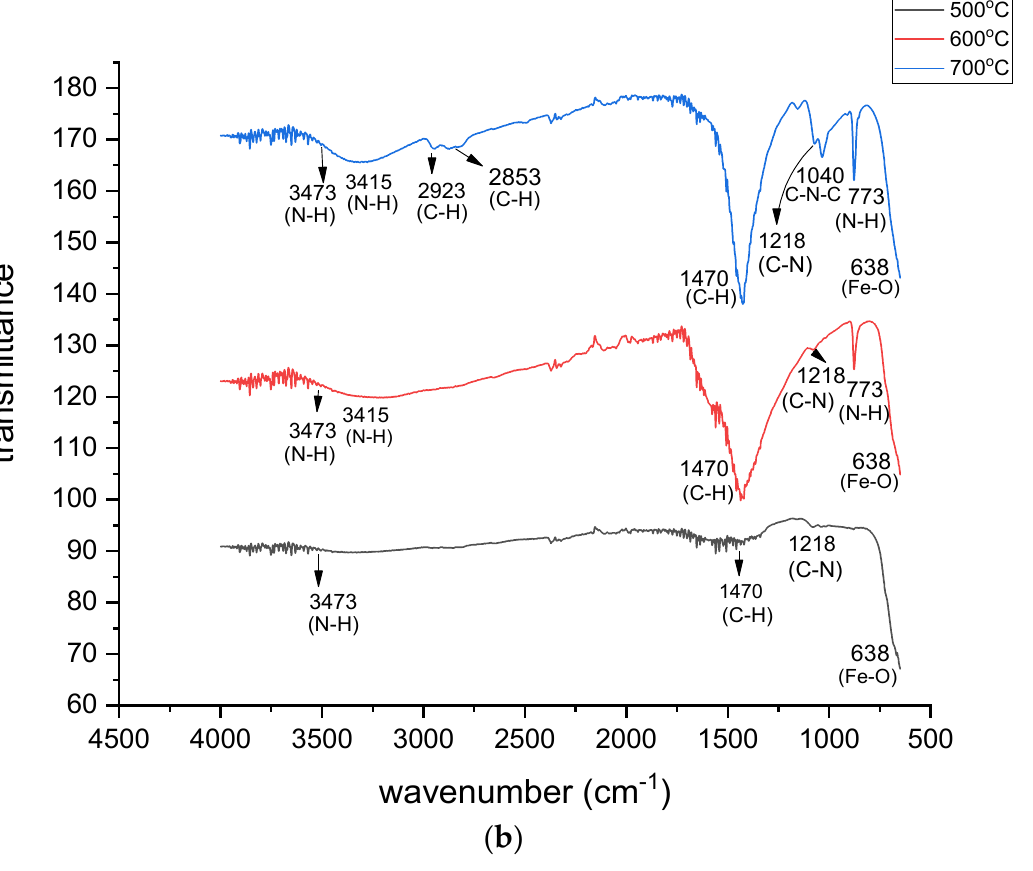
Figure 1. ( a ) FTIR spectra of pristine MgFe 2 O 4 adsorbent calcined at different temperatures. ( b ) FTIR spectra of amine-functionalized magnesium ferrite nanoparticles calcined at different tem- peratures.